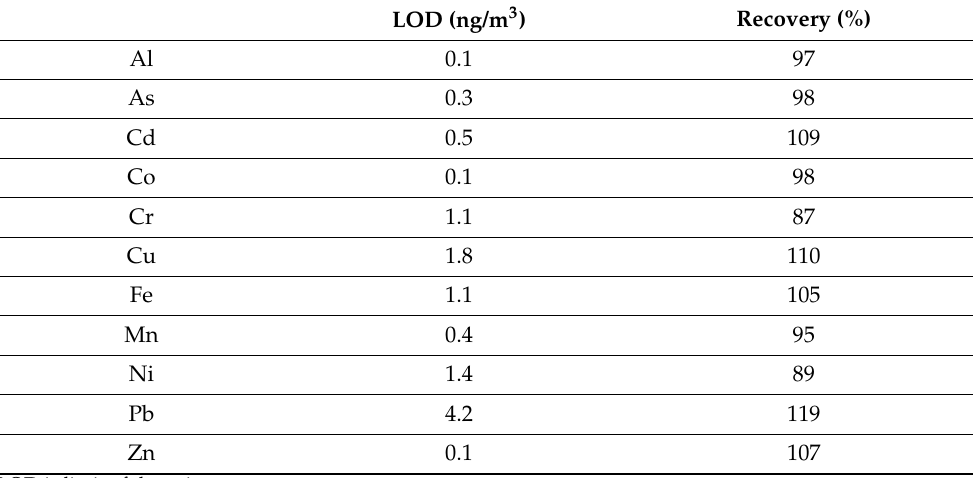
Table 1. Limits of detection and recovery rate for different elements.